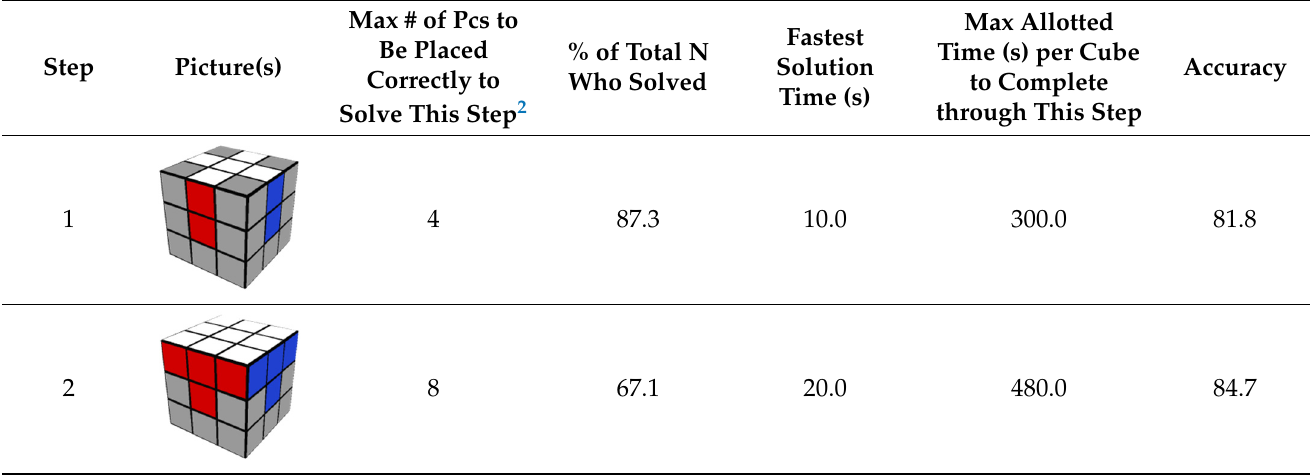
Table 1. Summary of Each Step and Performance.